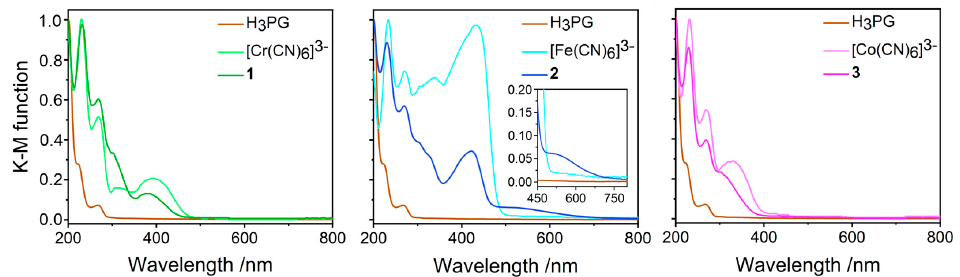
Figure 7. Electronic absorption UV-Vis spectra of 1 – 3 in the solid-state compared to H 3 PG and respective (PPh 4 ) 3 [M(CN) 8 ] · nH 2 O precursors. The reflectance spectra were recalculated into the Kubelka-Munk finction. Colors: 1 —green, 2 —blue, and 3